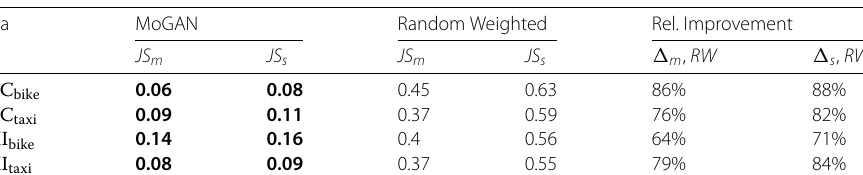
Table 3 JS divergences of the distributions of the CPC scores with the Random Weighted model. For each model, we report the JS divergence between mixed set and test set (column JS m ) and the JS divergence between synthetic set and test set (column JS s ). The last two (cid:5) x , Z -like columns represent the improvement of MoGAN compared to the Random Weighted model on the mixed and the synthetic sets (columns (cid:5) m , RW and (cid:5) s , RW ) Data MoGAN